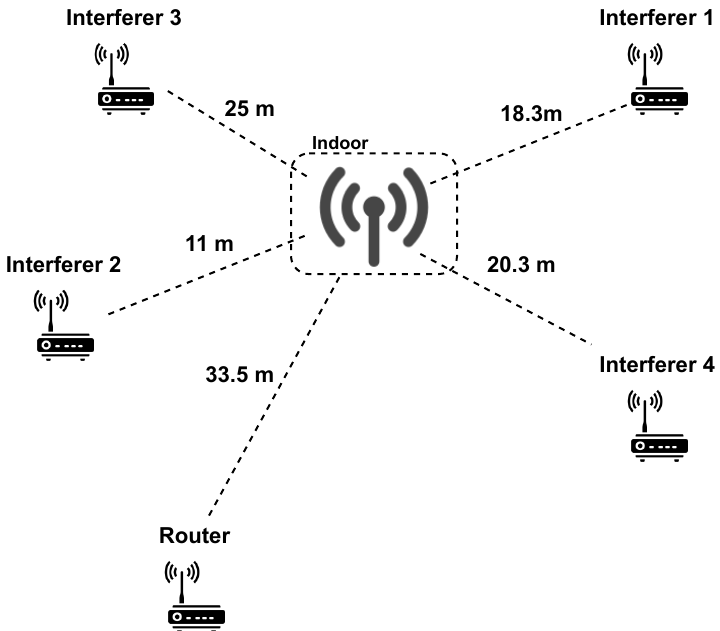
Figure 2. Experimental